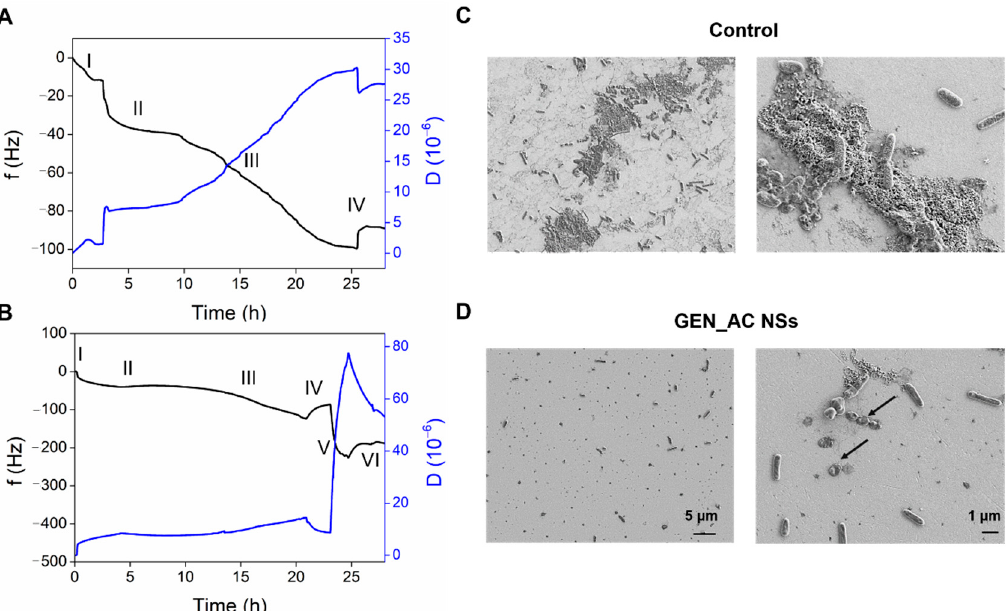
Figure 5. Interaction of GeN_AC NSs with P. aeruginosa assessed by QCM-D. ( A , B ) The shift in frequency ( Δ f 5 ) and dissipation ( Δ D 5 ) are represented with black and blue lines, respectively. The numbers indicate: I—the baseline establishment, II—QCM inoculation and III—growth of P. aeruginosa sessile cells, IV—baseline after removal of the loosely attached cells, V—insertion and circulation of GeN_AC NSs and VI—washing with PBS. SEM images of the QCM-D gold disks non-treated ( C ) and treated with GeN_AC NSs ( D ) at different magnification.